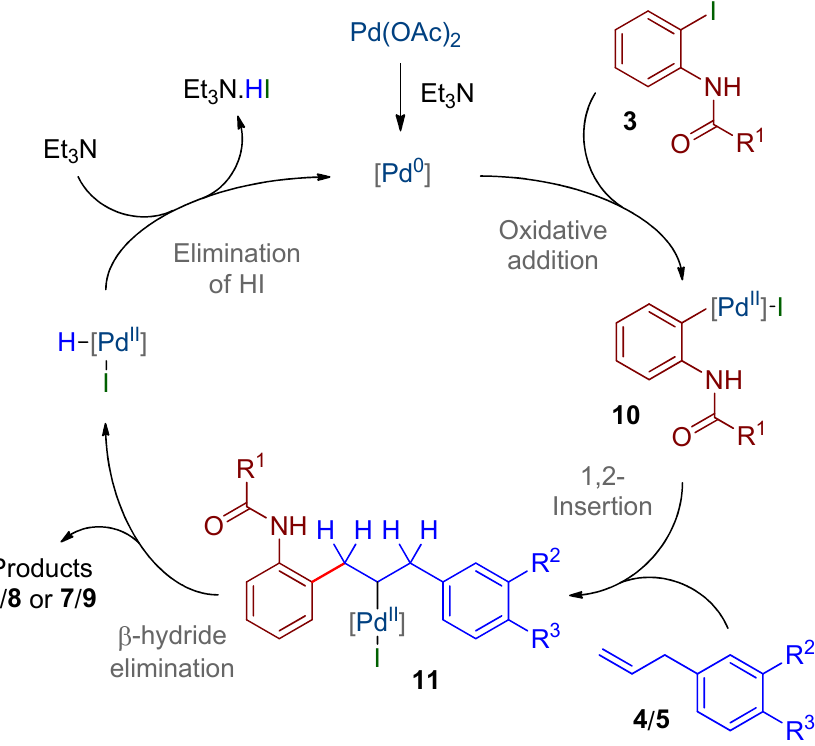
Scheme 3. Simplify mechanism of the Heck cross-coupling reaction of 2-amidoiodobenzenes 3 with allylbenzene derivatives 4 or 5